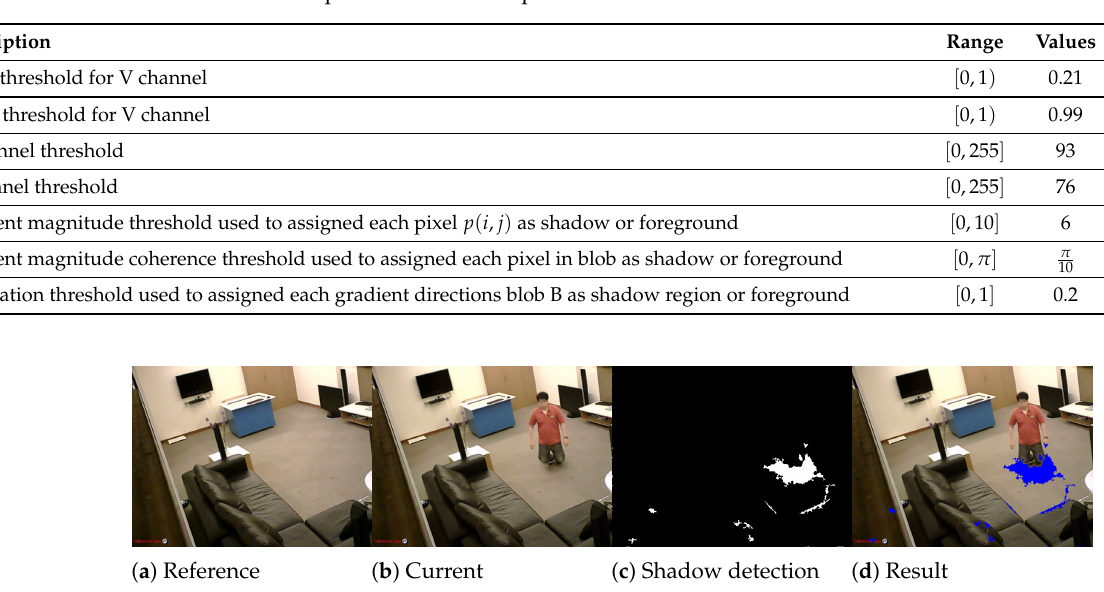
Table 1. Description and values of parameters threshold.